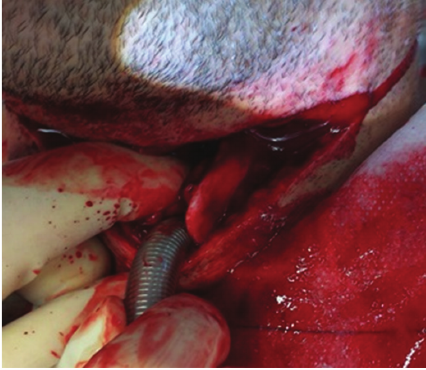
Figure 2: The patient was initially intubated via the open wound.